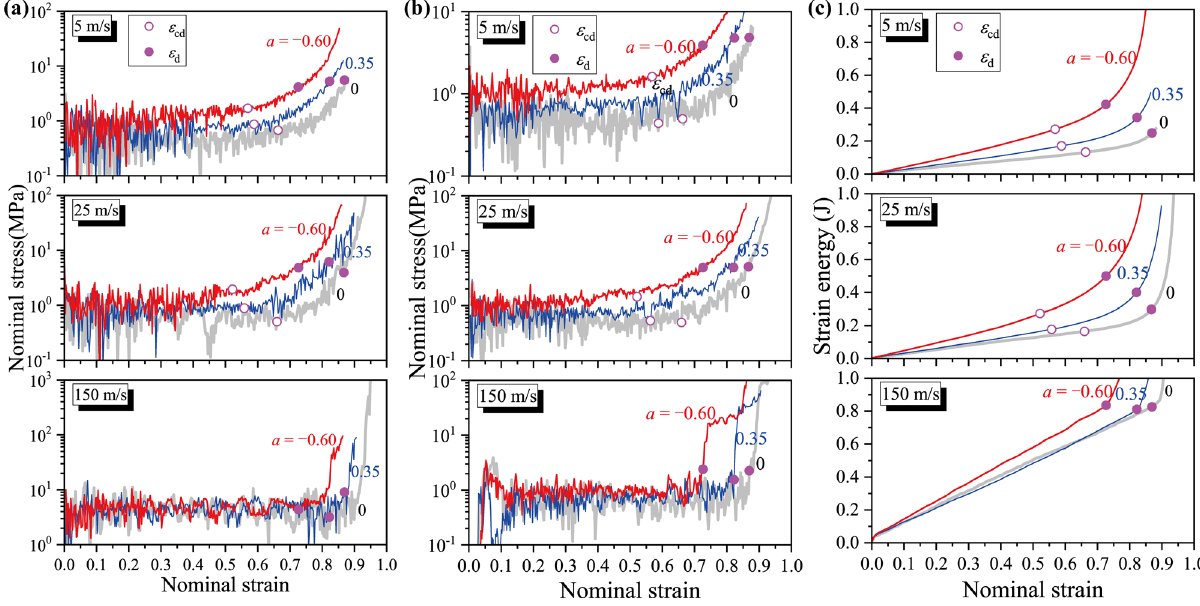
Figure 4: Curves of ( a ) impact end stress, ( b ) support end stress, and ( c ) strain energy of the Voronoi models under uniaxial impact compression.